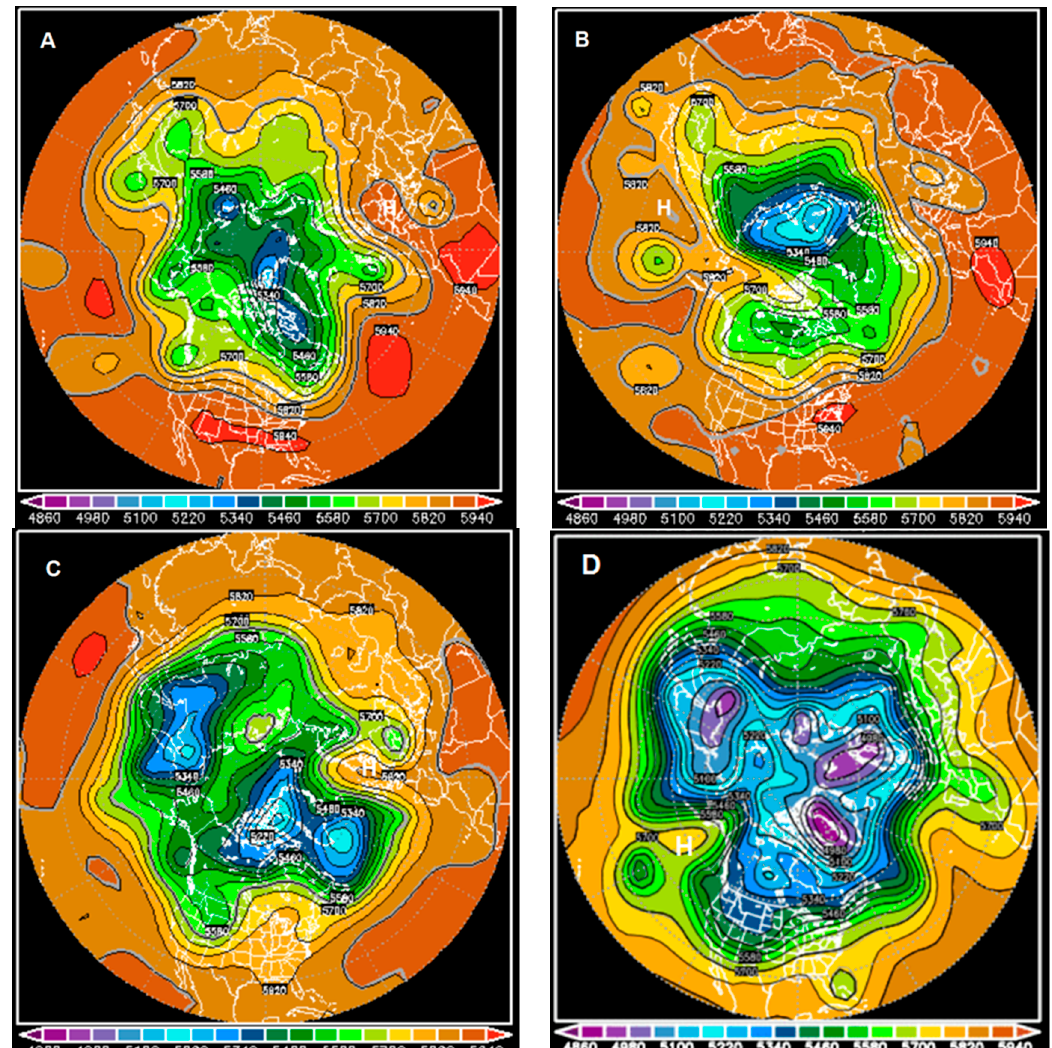
Figure 4 . As in Figure 2 for the GEFS 48 h forecast, except for 12 h earlier. The block center is identified with a white ‘H’. BI for each event is ( A ) 1.98; ( B ) 1.82; ( C ) 4.19; and ( D )